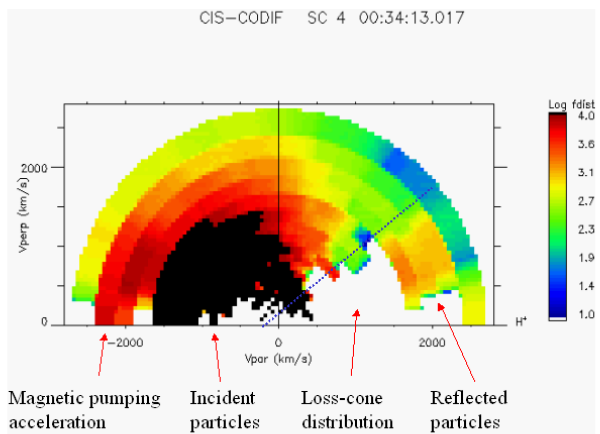
Fig. 5. Proton distribution function in the sixth data acquisition pe- riod in the cavity at 00:34:05UT. Several populations with different kinetic characteristics are identified. The feature of loss-cone dis- tribution is lined